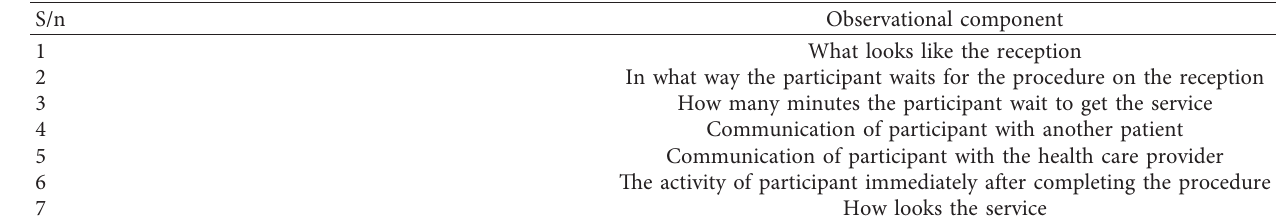
Table 3: Area to be